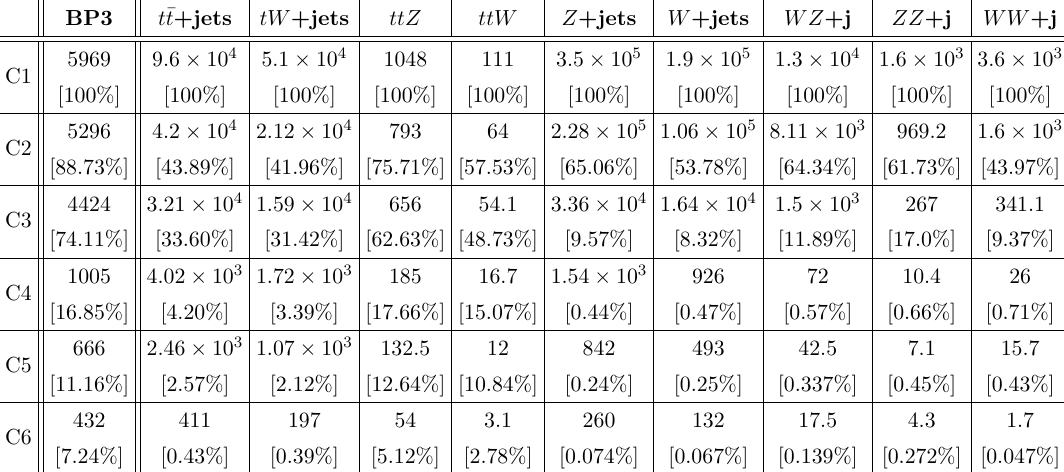
Table 4. The cut efficiency and expected number of events after the corresponding cuts for the signal and all the backgrounds contribute to the fatjets + /E integrated luminosity. The effectiveness of different selection cuts can be followed in the form a cut flow from top to bottom after applying (C1) Preselection cuts, (C2) /E at least one b-tag within J